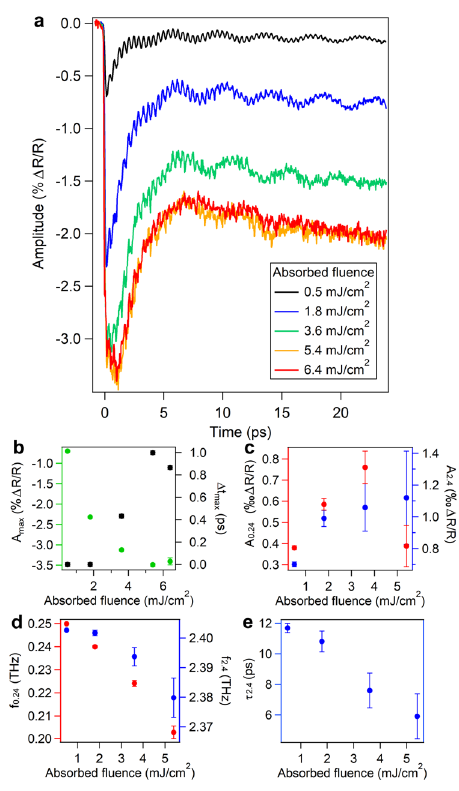
Fig. 4 Time-resolved infrared re fl ectivity measurements. a Experimental data; fi t results for b maximum Δ R / R variation (left axis, green) and its time position with respect to the one at the lowest fl uence (right axis, black), c initial amplitude for the shear mode (left axis, red) and for the second-lowest A 1 mode (right axis, blue), d shear mode (left axis, red) and second-lowest A 1 mode frequencies (right axis, blue), e second-lowest A 1 mode time-decay constant. The error bars represent one standard deviation